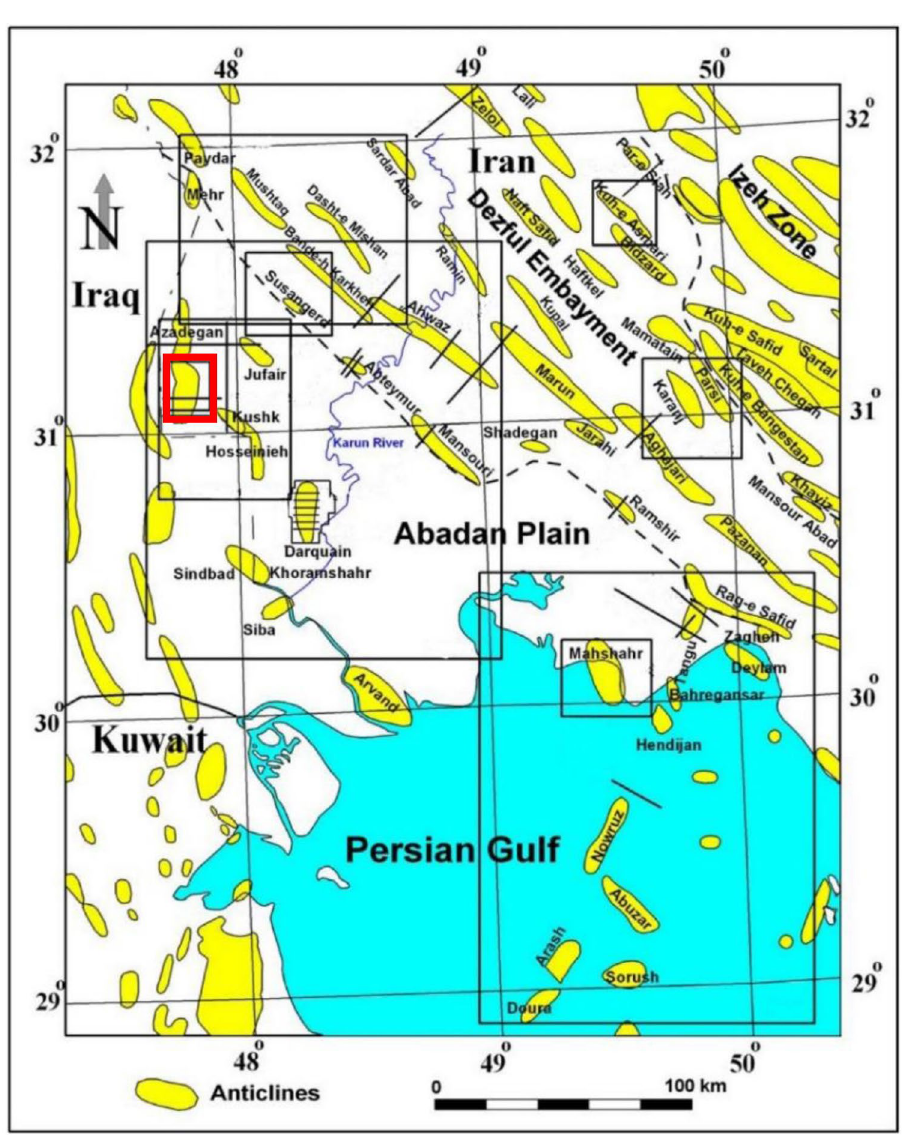
Fig. 1 Structural map of the Abadan Plain. Major anticlines appear as elongated domes. The location of studied area and seismic profiles are outlined with red polygon (Abdollahie Fard et al.